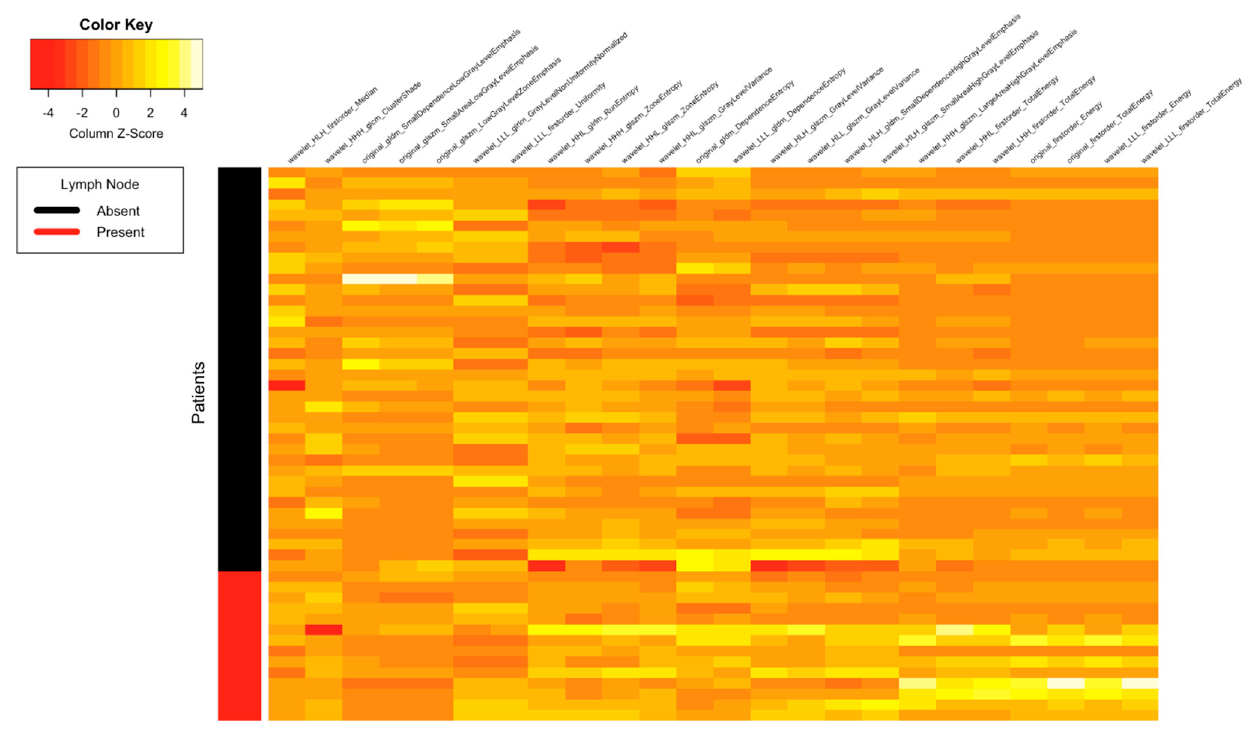
Figure 1. Heat map showing correlation between different radiomics and ADC features with the two classes of lymph node (absent and present).